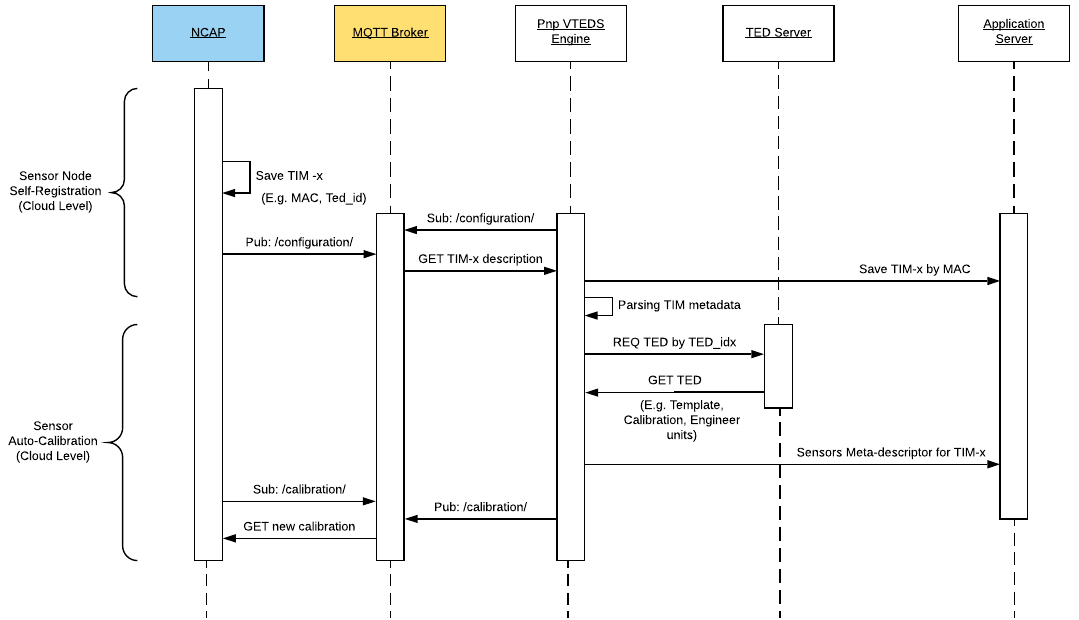
Figure 8. Self-registration and auto-calibration of the sensor node in the